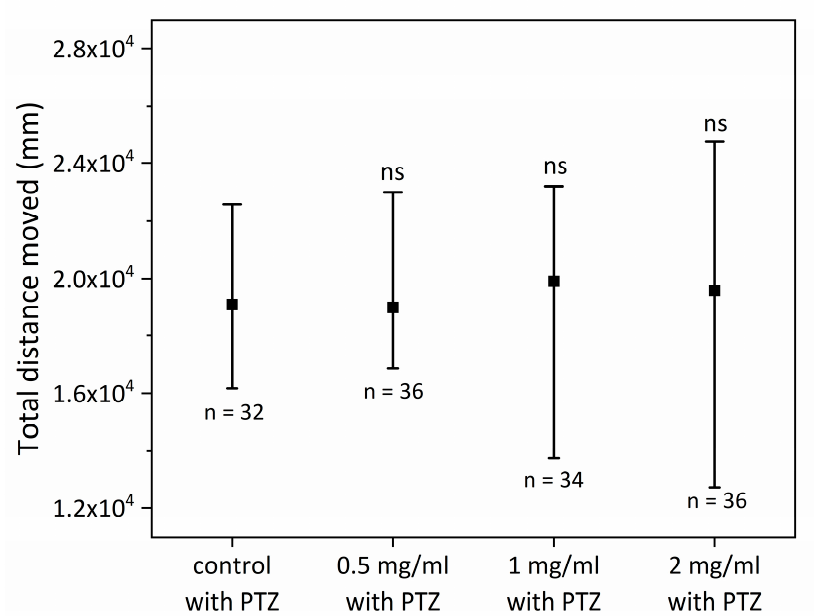
Figure 4. Comparison of different groups exposed to PTZ in long-term exposure protocol; ns—not signi fi cant.